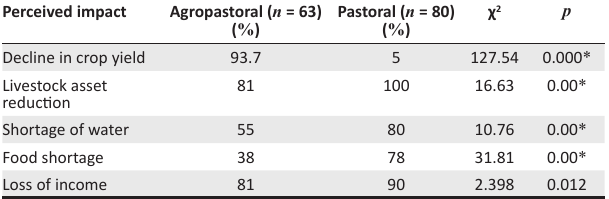
TABLE 12: Perceived impact of climate change and variability in the study area. Perceived